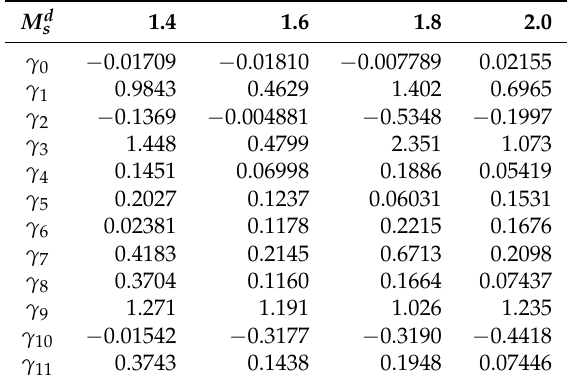
Table 7. Coefficient parameters γ i ( M d s ) for τ d in the regulation mode.